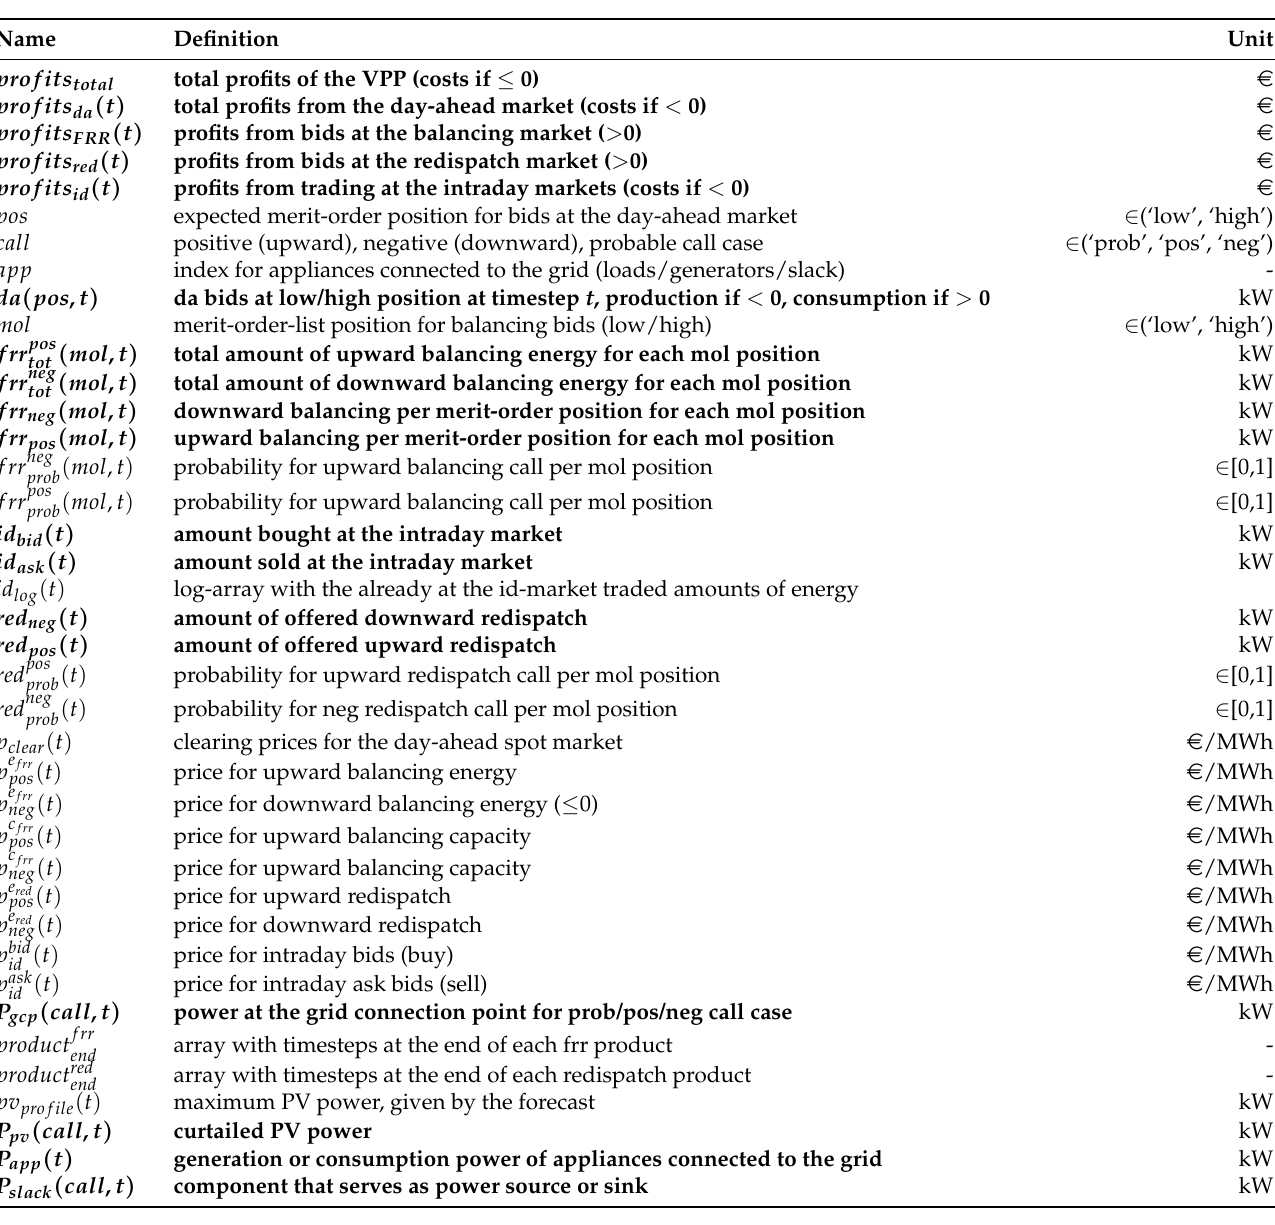
Table 3. Nomenclature of the mathematical model. Variables are displayed bold, parameters